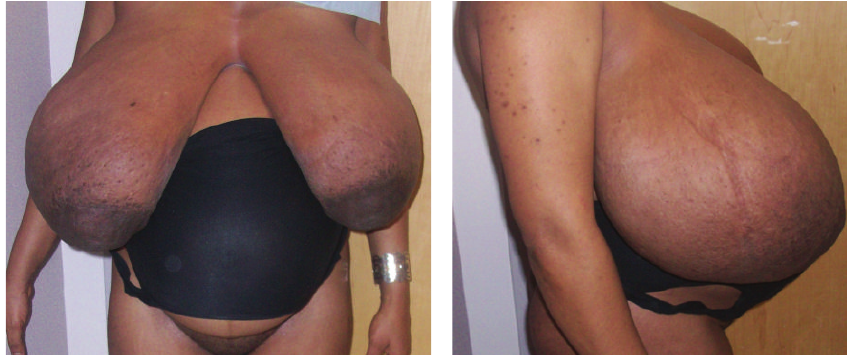
Figure 1: Patient with gestational gigantomastia at 37 weeks (initial presentation).